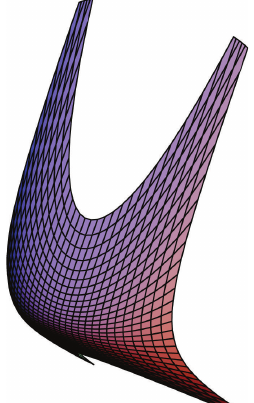
Figure 2: A spacelike (cid:3) timelike (cid:4) surface of revolution with positive (cid:3) negative (cid:4) curvature.